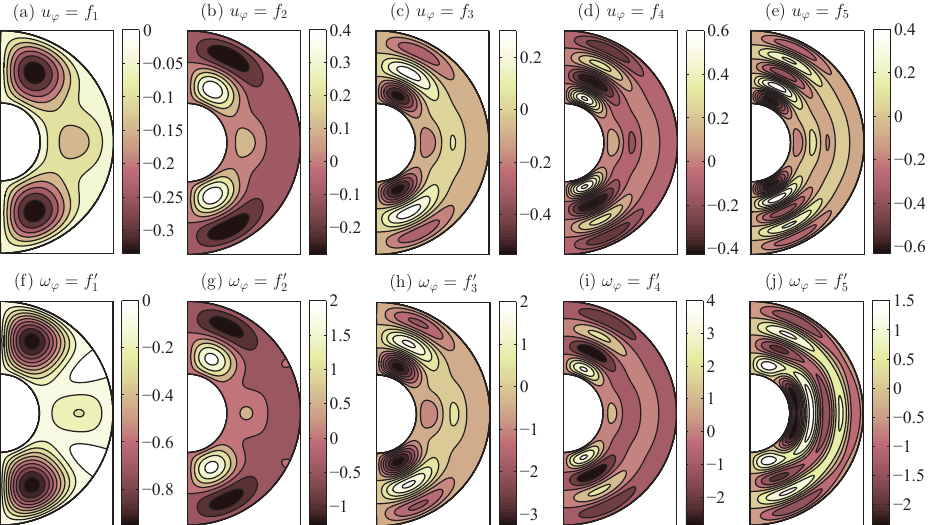
Figure 6. Non-oscillatory eigenmodes: Axisymmetric inertial wave structures in a rotating spherical shell. ( a – e ) Azimuthal components of velocity u ϕ = f n and ( f – j ) corresponding azimuthal vorticity ( 0 ) = 0 eigenmodes I = 15–11 of Table 2 component ω ϕ = f (cid:48) , n = 1, . . . ,5, associated with the (cid:60) ω n 55 and Figure 5. These are helical flows encircling the rotation axis, which is the left vertical edge in each